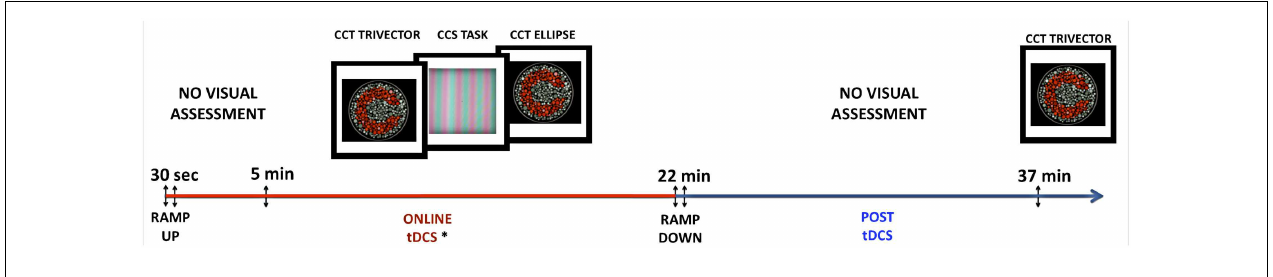
22min of stimulation, the current would be ramped down and the participant would have a 15-min break without performing visual tests. After the break, the tDCSTrivector test was repeated without